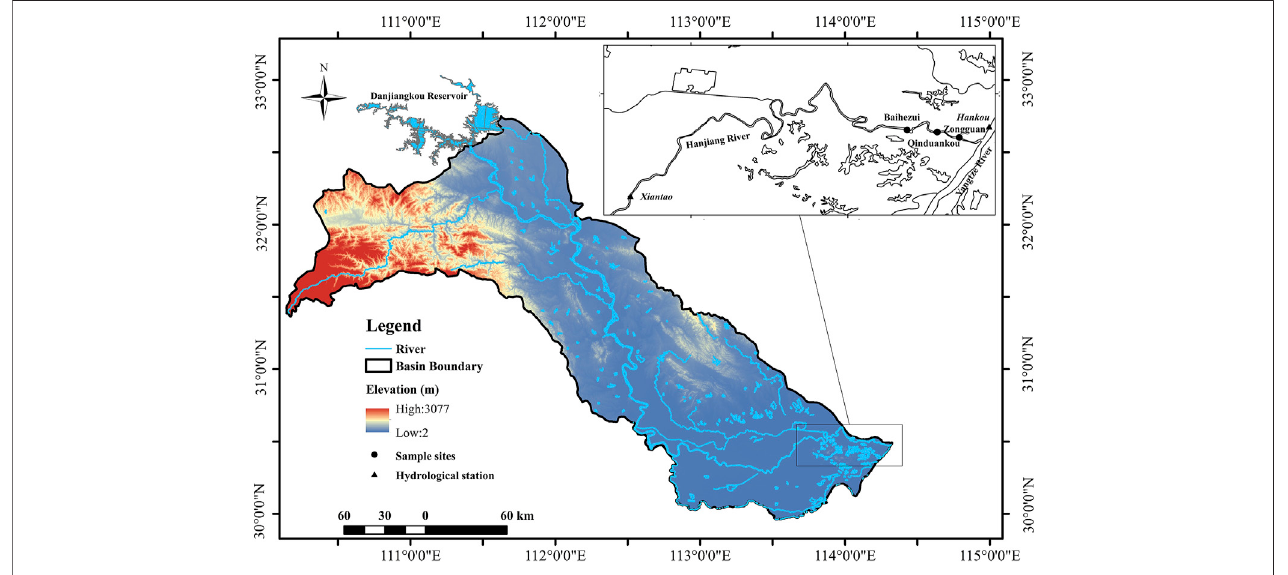
FIGURE1| Overviewofthestudyareaandsamplesites.WaterlevelsweremeasuredattheXiantaoStationfortheHRandattheHankouStationfortheYR.Water quality and Chl a were measured at three sample sites: Baihezui (BHZ), Qinduandou (QDK), and Zongguan (ZG).